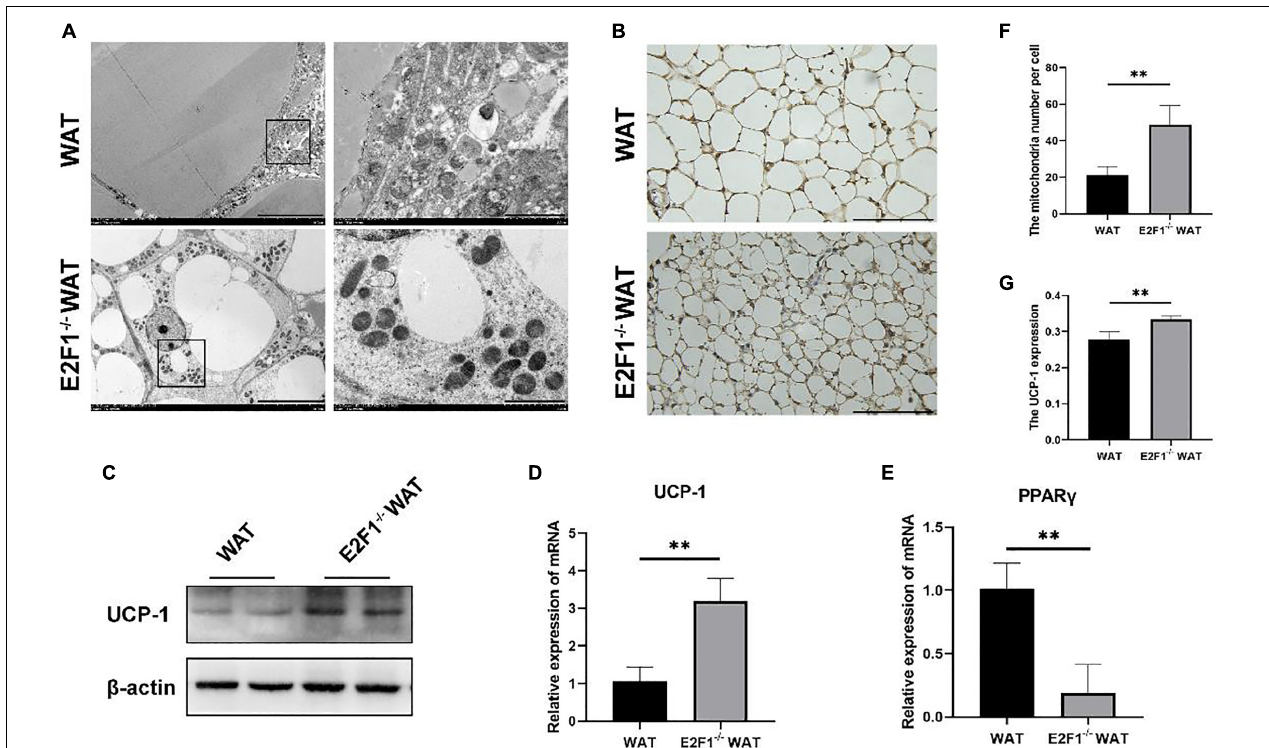
FIGURE 2 | E2F1 knockout increased the mitochondrial number and the UCP-1 expression in WAT in vivo . (A) Representative TEM images of WAT ultrastructures in WT and E2F1 − / − group. Scale bar, 10 µ m (left) and 2 µ m (right). (B) Representative IHC pictures of UCP-1 protein (brown stain) in WAT of WT and E2F1 − / − mice. Scale bar, 100 µ m. Magnification, 400 × . (C) Representative Western Blot images of UCP-1 protein level in WT and E2F1 − / − WAT, n = 3. (D) The UCP-1 mRNA levels in WT and E2F1 − / − WAT in mice by qRT-PCR. (E) The PPAR γ mRNA levels in WT and E2F1 − / − WAT in mice by qRT-PCR. (F) Quantitative analysis of mitochondrial number per cell in WT and E2F1 − / − WAT. (G) The expression level of UCP1 staining in WAT was indicated with a stained positive index (integrated density/area) in WT and E2F1 − / − WAT. ∗ P < 0.05, ∗∗ P <